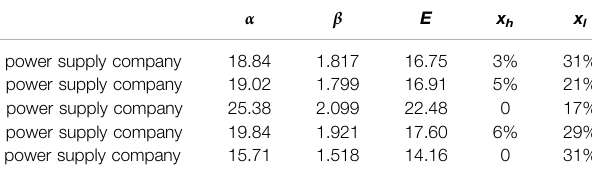
TABLE 4 | Corresponding parameters of equipment of all af fi liated companies.